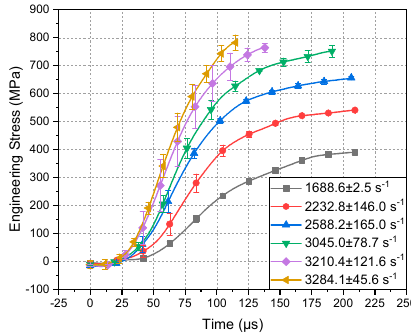
Figure 10. The evolution of stress with increasing strain rate.